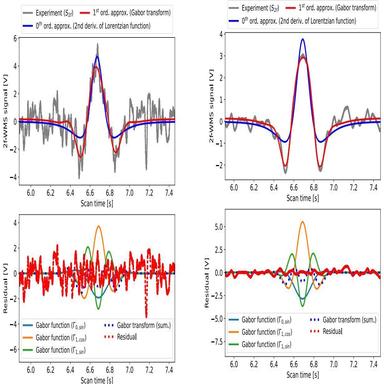
Experimental and model (Gabor transformed) data with corresponding residuals for Scenario A (SNR = 8) in the left panels and B (SNR = 22) in the right panels. Residual of the Gabor transform is depicted in red (dotted line). Blue dotted line represents the product of selected envelope function (Gausian profile) and a sum of three goniometric (sine and cosine) functions (depicted as turquoise, orange, and green lines) having individual amplitudes and phase-shifts adjusted by leastsquare fitting to residual o